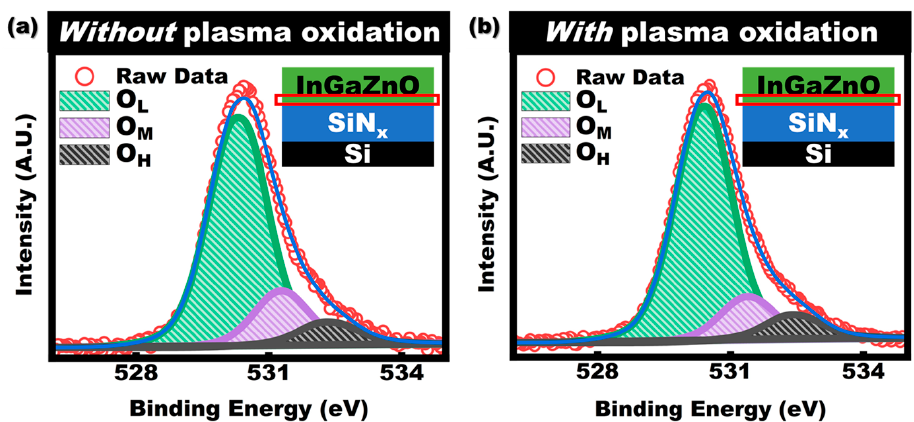
Figure 4. XPS results for surface of SiN x thin film ( a ) without ( b ) with plasma oxidation.